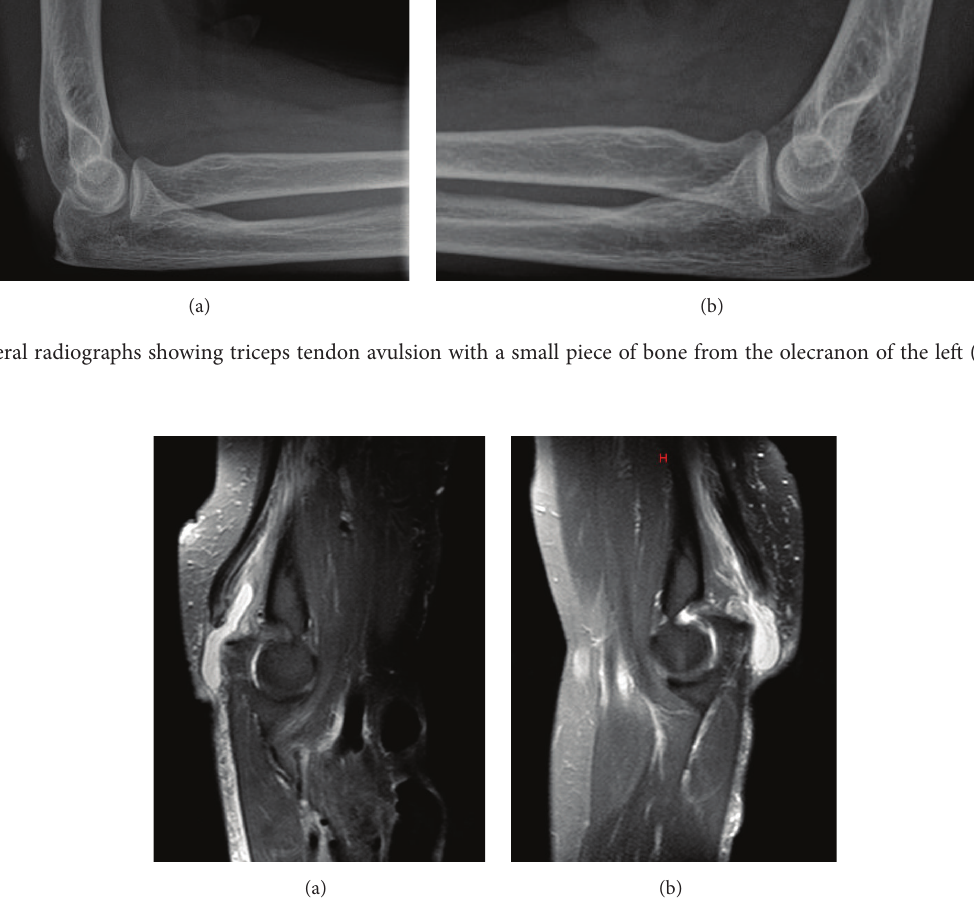
Figure 2: Magnetic resonance images of right (a) and left (b) elbows demonstrating complete avulsion of triceps tendon from the